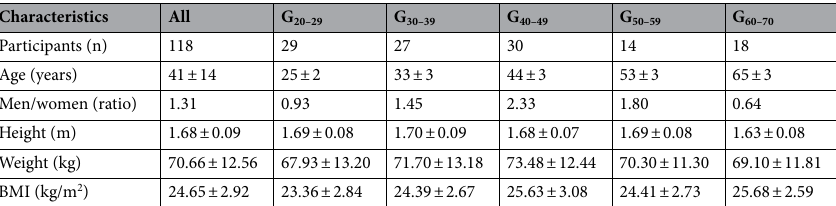
Table 1. Characteristics of the participants. Data are mean ± standard deviation. BMI body mass index, G 20–29 20–29 years old group, G 30–39 30–39 years old group, G 40–49 40–49 years old group, G 50–59 50–59 years old group, G 60–70 60–70 years old